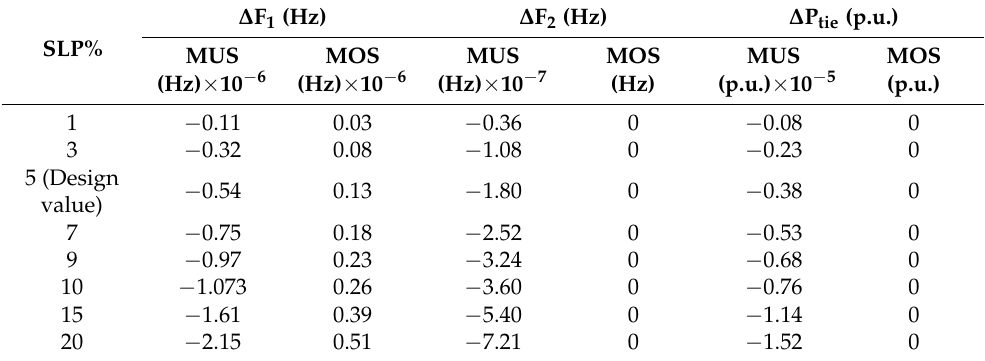
Table 5. Transient specifications based on ULC-fuzzy PIDF controller for different SLP.